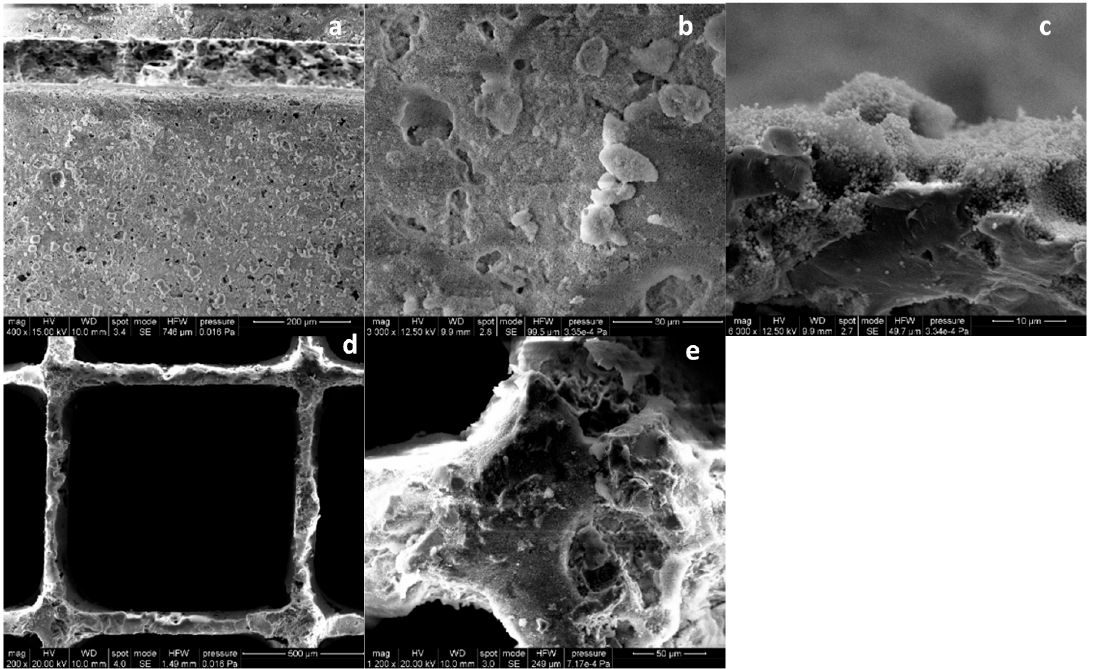
Figure 3. SEM images of WSN monolith: ( a ) top view of the channel; zoom view of ( b ) washcoat surface ( c ) cordierite wall with washcoat ( d ) front view of the monolith channel; ( e ) zoom view of the corner of the channel.